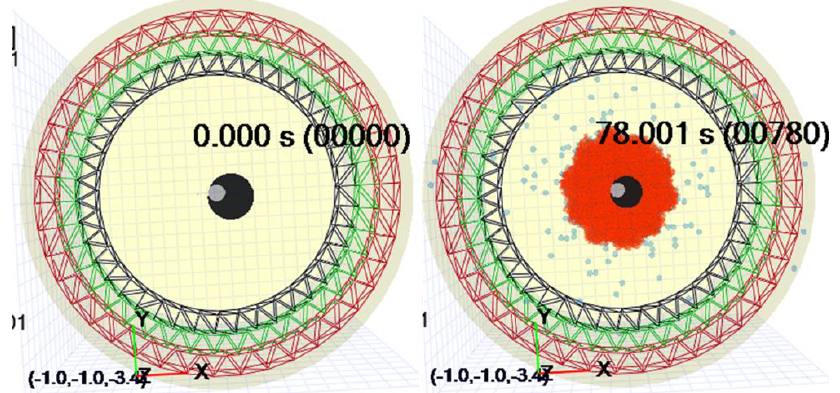
Figure 4. Top views of probe region at beginning and end.